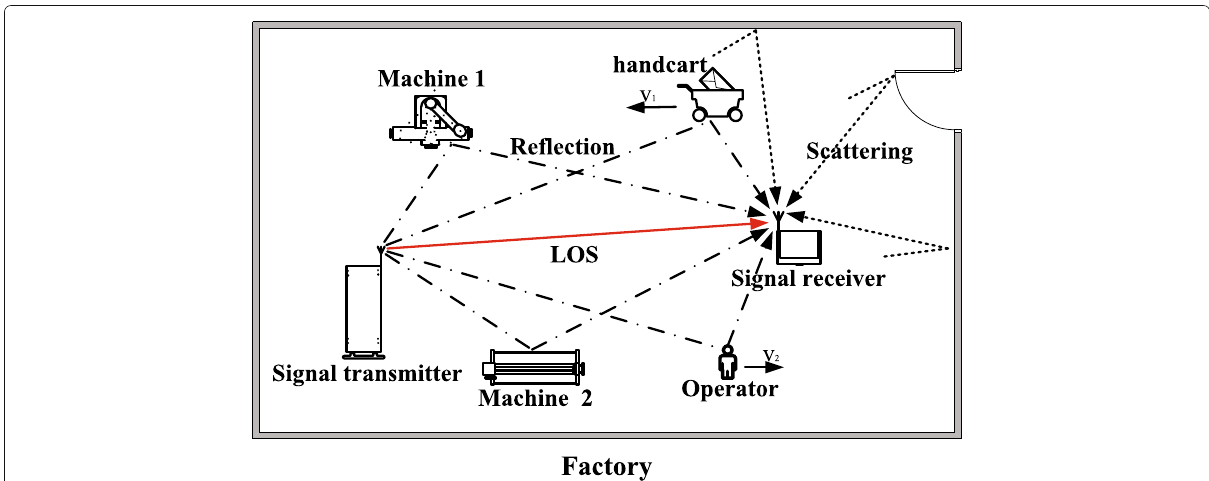
Fig. 2 The schematic diagram of IIoT channel scene. This figure illustrates the IIoT communication scenario